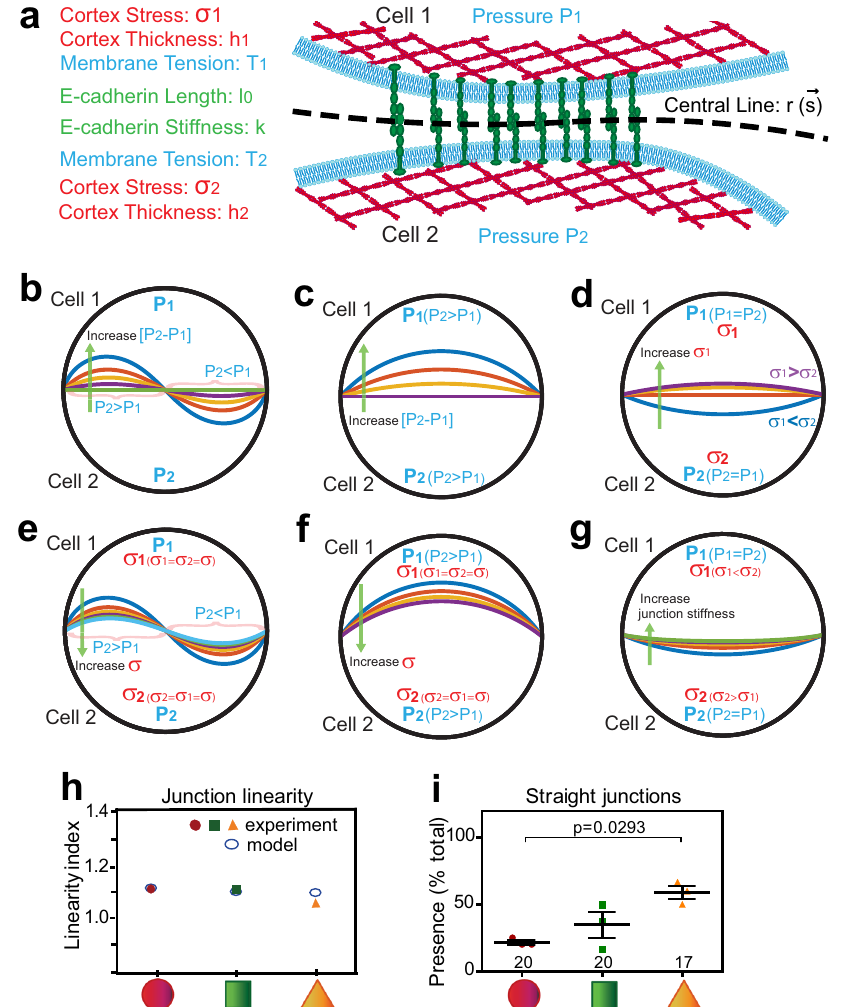
Fig.4| Modellingtheroleofviscoelasticitypropertiesindeterminingjunction con fi guration and maturation. a Diagram showing junction representation and parametersusedinthemodellingofjunctioncon fi guration(curvilinearorstraight) under different elasticity conditions. Zoom of the junctional region showing the parameters for cell 1 and cell 2 described in the model. b – g Distinct scenarios in which a curvilinear or sinusoidal junction appears and can be straightened up are shownbylinesofdifferentcoloursandprogressivecurvature.Distinctintracellular pressurebetweenneighboursispredictedtobendtheircontactinginterface,which can be reversed by various mechanisms. b , e Under conditions of constant intra- cellularpressure( P 1 , P 2 ),discrete,localizedvariationsofpressurefromcell1orcell 2 leads to an undulated or “ wavy ” contacting interface. The latter can be straigh- tened up by local realignment of intracellular pressure ( b ) or increasing cortex stress σ ( e ). c , f Unequalglobalintracellularpressureamongcells( P 2 > P 1 )resultsin a bulging, curvilinear junction. The interface curvature can be counteracted by reducing the difference in intracellular pressure between neighbours ( c ) or an